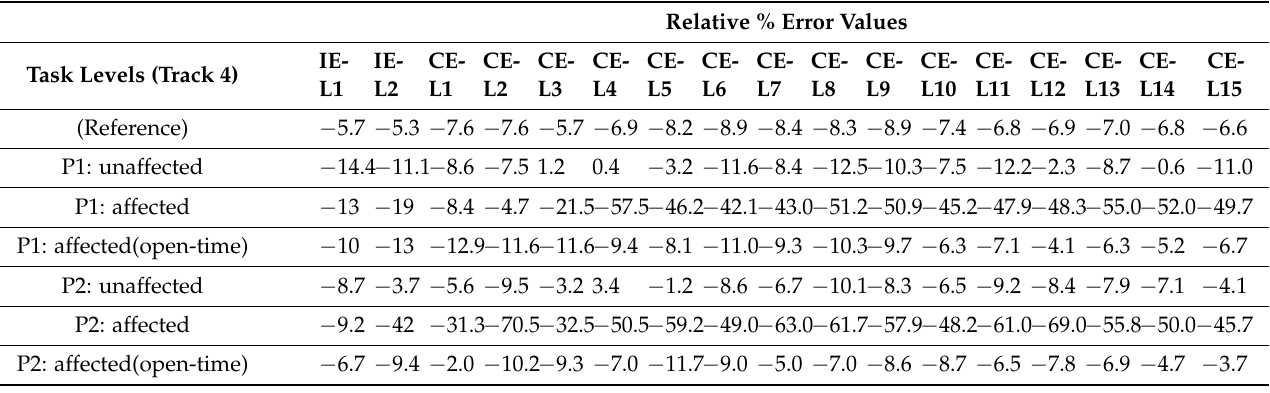
Table 6. The variation of relative % error parameter with the task levels of both the environments designed on track